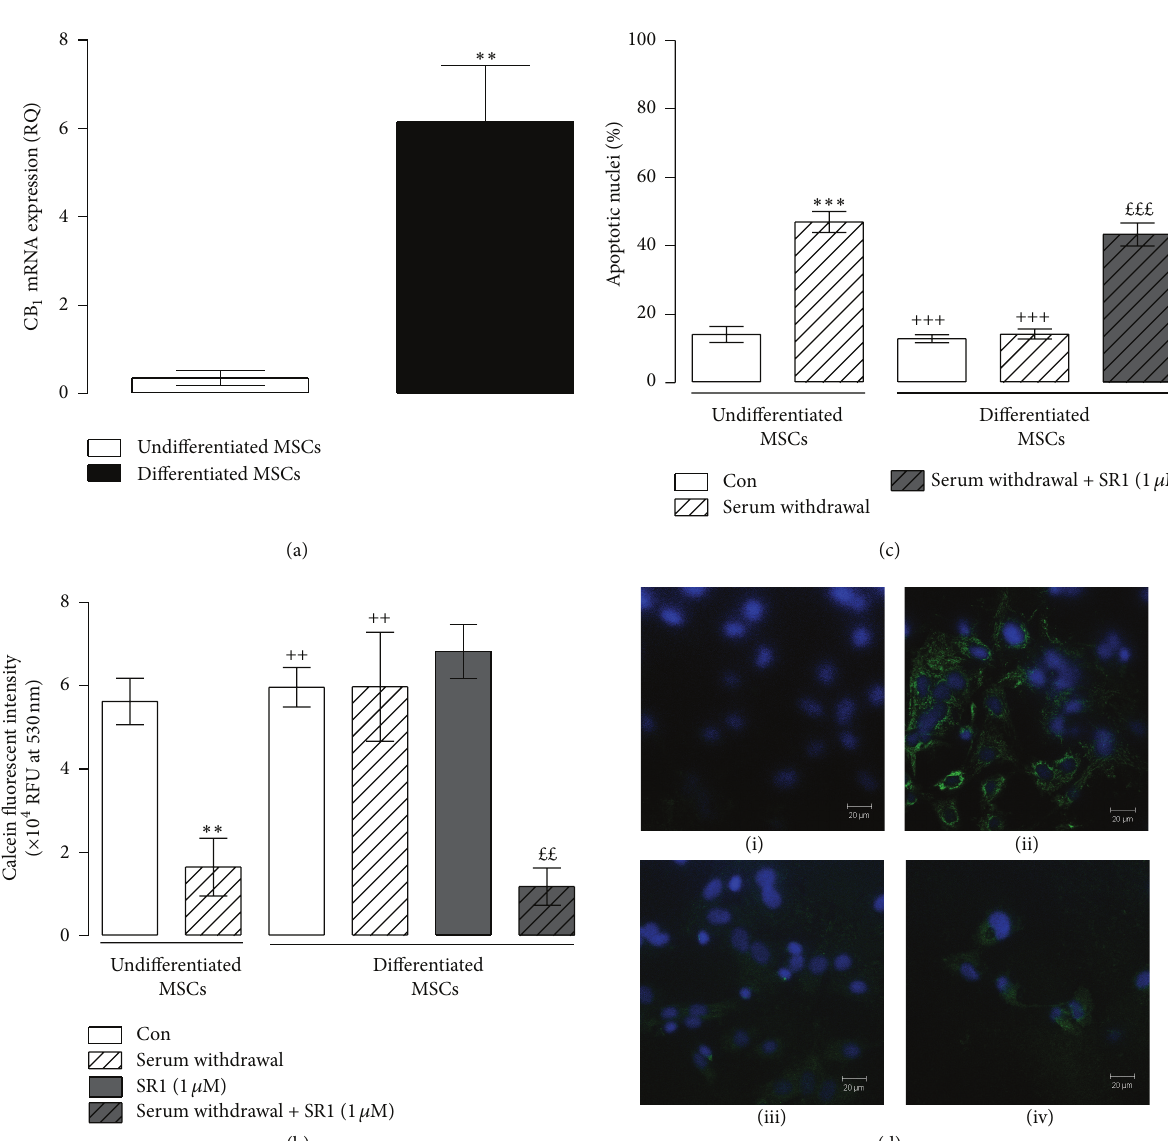
Figure 1: The CB 1 receptor is increased during early osteogenesis and is essential for the survival of differentiated MSCs. (a) Differentiated MSCs displayed a significant increase in CB 1 receptor mRNA expression after 2 weeks of differentiation compared to undifferentiated MSCs ( ∗∗ 𝑃 = 0.002 , Student’s unpaired 𝑡 -test, 𝑛 = 5 ). (b) Serum withdrawal significantly reduced the metabolic function of undifferentiated MSCs (Con; ∗∗ 𝑃 < 0.01 , 1-way ANOVA and Newman-Keuls, 𝑛 = 5 ). In differentiated MSCs, serum withdrawal had no effect on metabolic function, and serum deprived differentiated MSCs displayed significantly greater metabolic function compared to serum deprived undifferentiated MSCs ( ++ 𝑃 < 0.01 , 1-way ANOVA and Newman-Keuls, 𝑛 = 5 ). Treatment of differentiated MSCs with SR141716 (SR1, 1 𝜇 M; 24 hours) blocked the ability of differentiated MSCs to survive serum withdrawal ( ££ 𝑃 < 0.01 , 1-way ANOVA and Newman-Keuls, 𝑛 = 5 ). (c) Serum withdrawal induced a significant increase in the numbers of undifferentiated MSCs displaying apoptotic nuclei (Con; ∗∗∗ 𝑃 < 0.001 , 1-way ANOVA and Newman-Keuls, 𝑛 = 4 ) compared to undifferentiated MSCs maintained with serum. Differentiated MSCs survived serum withdrawal compared to serum deprived undifferentiated MSCs ( +++ 𝑃 < 0.001 , 1-way ANOVA and Newman-Keuls, 𝑛 = 4 ). Treatment of differentiated MSCs with SR1 blocked the ability of differentiated MSCs to survive serum withdrawal compared to serum deprived differentiated MSCs ( £££ 𝑃 < 0.001 , 1-way ANOVA and Newman-Keuls, 𝑛 = 4 ). (d) Representative images of caspase-3 activity in undifferentiated MSCs exposed tocontrol(i)and(ii)serumwithdrawalconditionsandcaspase-3activityindifferentiatedMSCsexposedtocontrol(iii)andserumwithdrawal in the presence of SR1